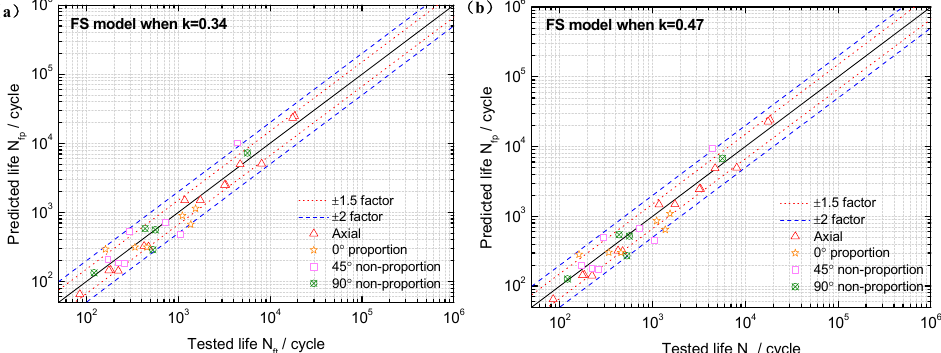
Figure 3. Comparison between tested lives and predicted lives using the FS model when ( a ) k = 0.34 and ( b ) k = 0.47 for GH4169.